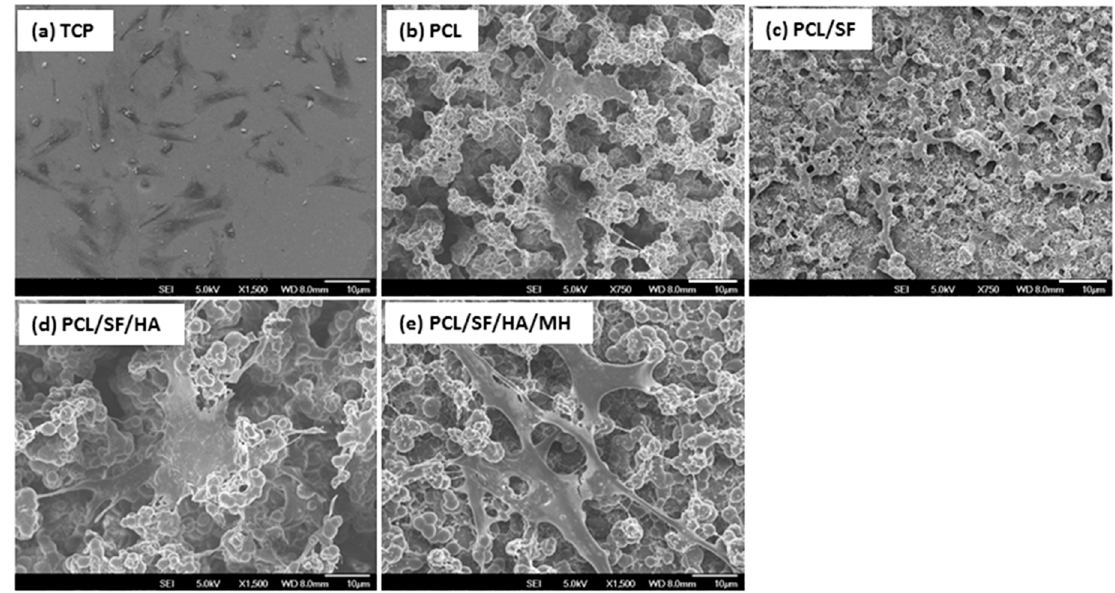
Figure 8. FESEM images showing the cell-biomaterial interactions on ( a ) TCP, ( b ) PCL ( c ) PCL/SF ( d ) PCL/SF/HA ( e ) PCL/SF/HA/MH micro/nanoparticles (Scale bar: 10 µ m).